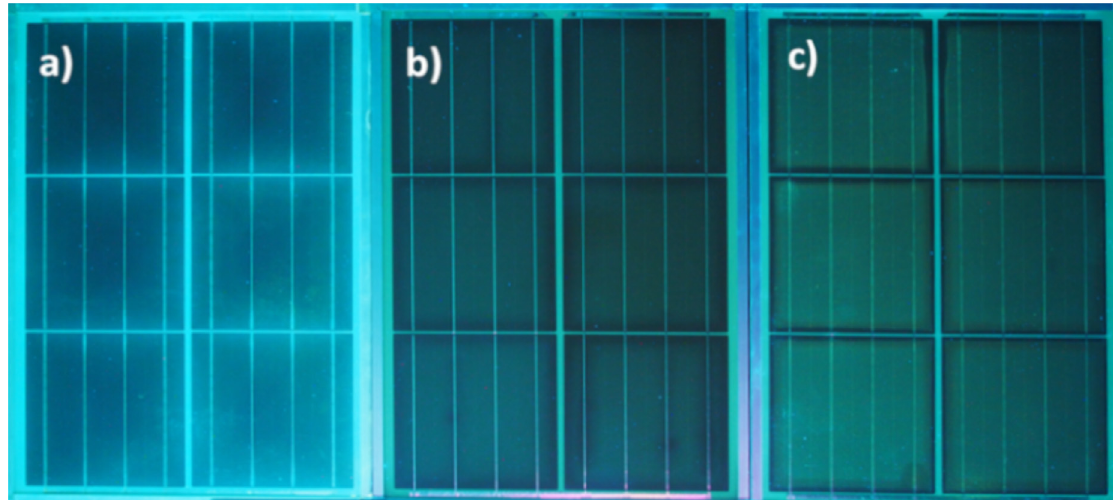
Fig. 11. UVF images of test modules; (a) after DH storage (Tropical 1) for 2000 h, (b) after natural weathering (outdoors) for 1.5 years and (c) after exposition to arti fi cial sunlight (climate chamber; 1000 W/m 2 ) for 1000h.